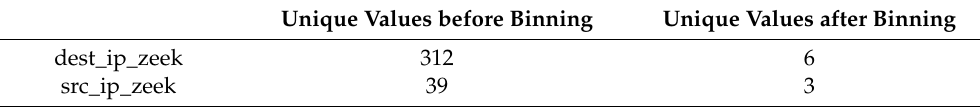
Table 8. Number of unique values before and after binning for dest_ip and src_ip attributes. Unique Values before Binning Unique Values after Binning dest_ip_zeek